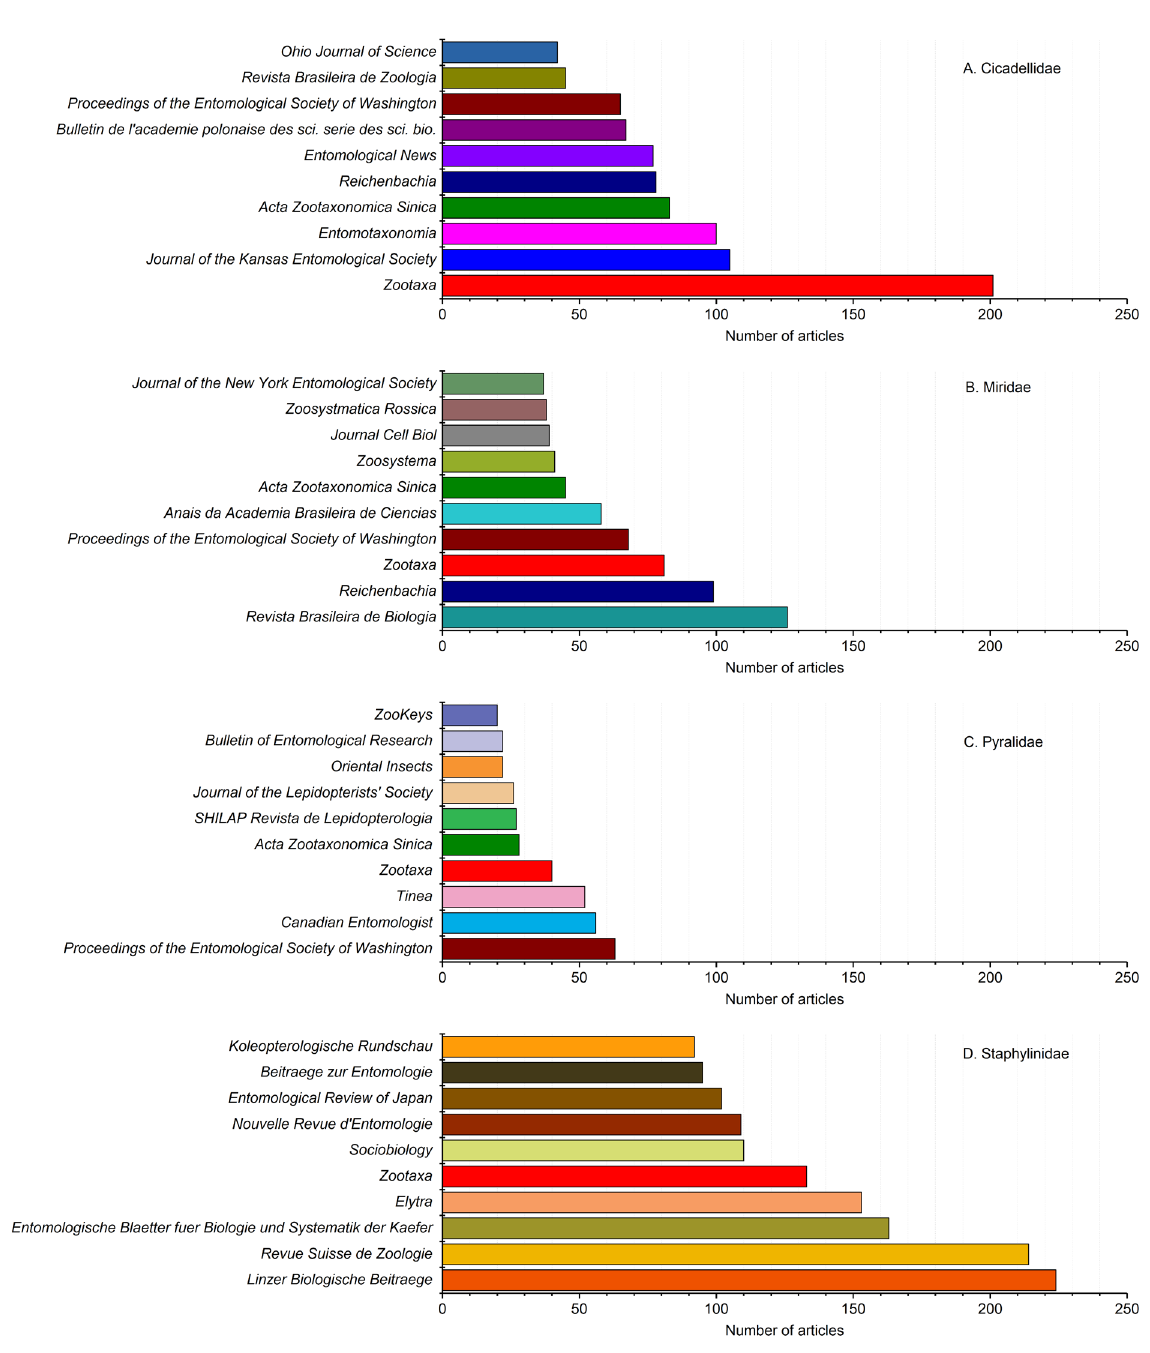
Fig 9. Top 10 of most utilized journals from 1946 to 2012. A . Cicadellidae. B . Miridae. C . Pyralidae. D .